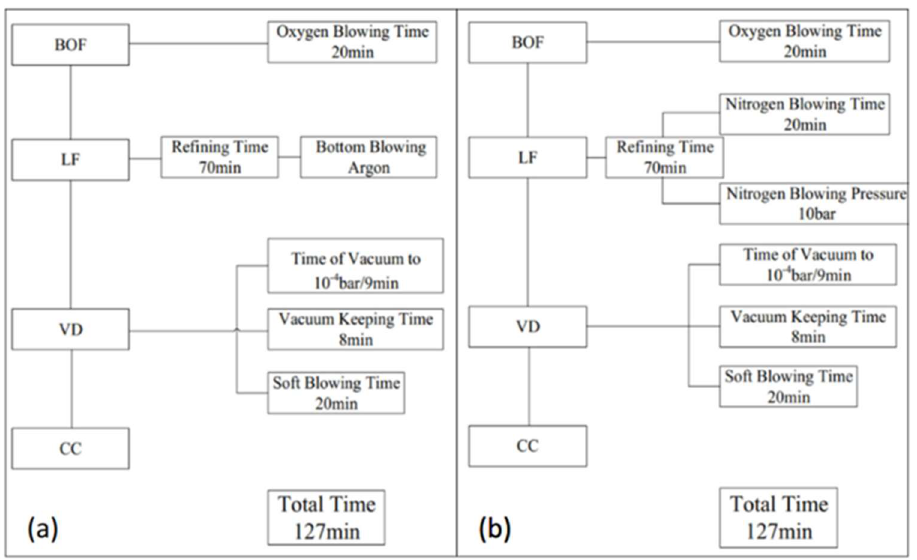
Figure 1. The process comparison of the two refining methods: ( a ) conventional method and ( b ) Nitrogen Elevating and Reducing Method (NERM).